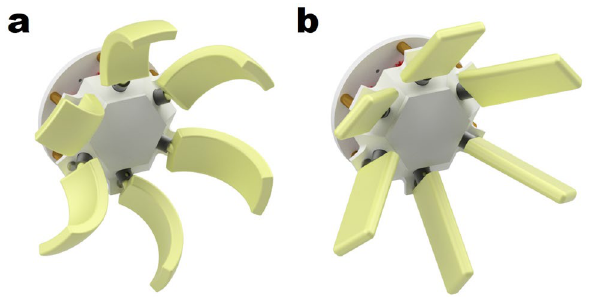
Figure 6. ( a ) ASPW using paddles with optimal design parameters. ( b ) ASPW using the initial paddle before 90 RPM. The thrust force of the optimal paddle design was 64.74 gf at 120 RPM. In the case of the initial paddle, Exp 1, a thrust force of 54.74 gf was generated at the same RPM. Therefore, the performance of the optimized paddle improved by 18.27% compared with that of the initial paddle. In other user conditions, the thrust force improved by 14.58% at 90 RPM and remained almost unchanged at 60 RPM. Figure 6 compares the shapes of the optimized and initial paddles.